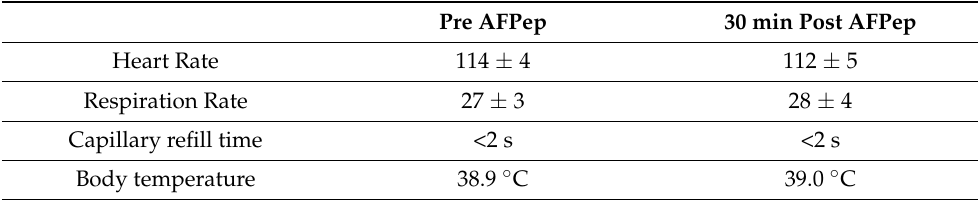
Table 5. Clinical parameters in unanesthetized dogs.